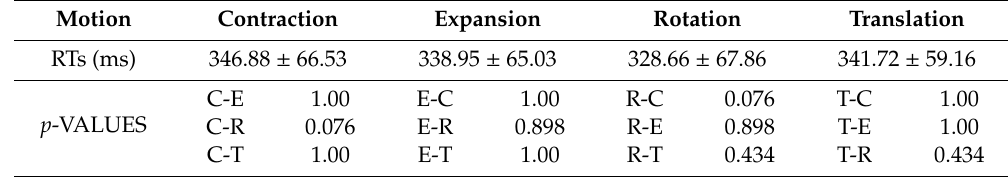
Table 1. Reaction times (RTs) and p -values for multiple comparison tests.